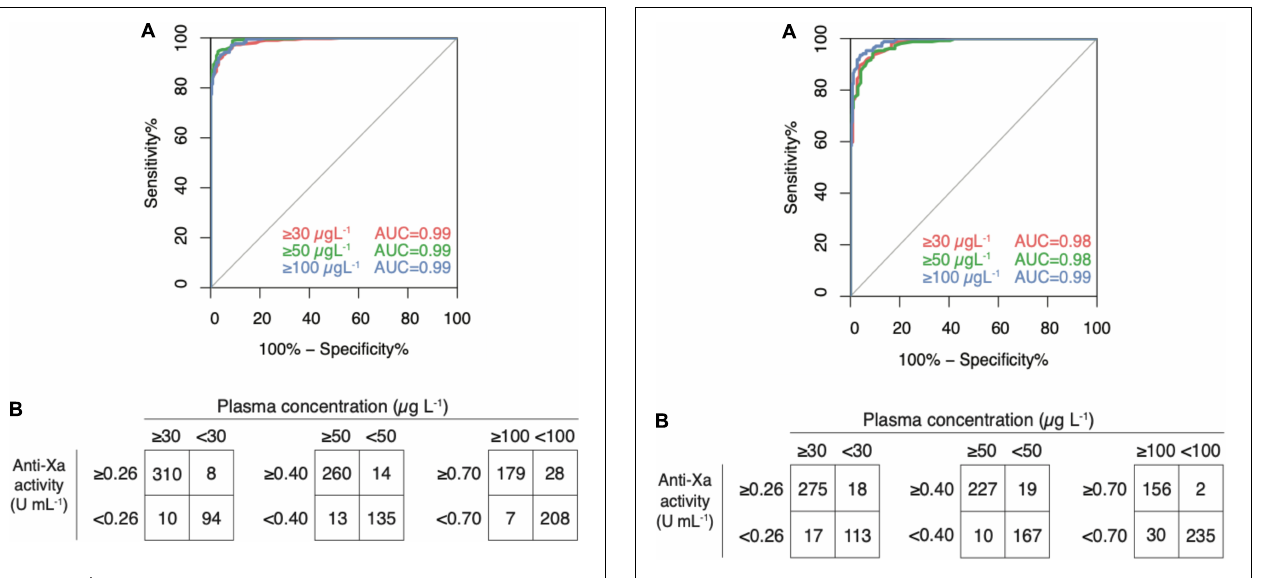
FIGURE 5 | Internal validation of a universal, heparin-calibrated anti-Xa assay for the measurement of rivaroxaban, apixaban, and edoxaban drug concentrations in clinical practice (verification dataset; n = 423). (A) Receiver-operating characteristics curve (ROC) showing the diagnostic accuracy. The area under the ROC curve was 0.98 for both the cut-offs 30 and 50 µ g L − 1 and 0.99 for 100 µ g L − 1 . (B) Confusion matrices at each cut-off. Drug levels above 30 µ g L − 1 were detected with a sensitivity of 94.2% (95% CI 90.8, 96.6; cut-off value 0.26 U mL − 1 ), drug levels above 50 µ g L − 1 with a sensitivity of 95.8% (95% CI 92.4, 98.0; cut-off value 0.40), and drug levels above 100 µ g L − 1 with a sensitivity of 98.7% (95% CI 95.5, 99.9; cut-off value 0.77). Specificities were 86.3% (79.2, 91.7), 89.8% (84.5, 93.7), 88.7% (84.2, 92.2), respectively.